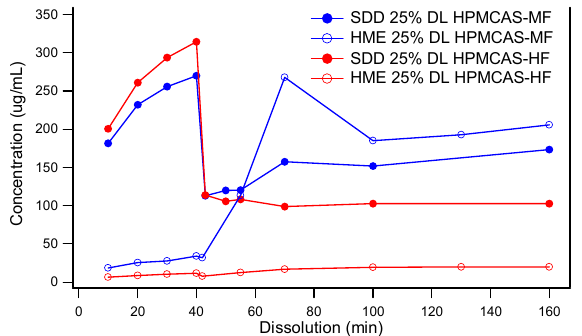
Figure 3. Two-Stage dissolution of MK-A solid dispersions prepared by spray drying or hot melt extrusion (Powders of the solid dispersions were used for the dissolution. For HME dispersions, the original HME extrudates were milled to a particle size of 213 µ m). DL, drug